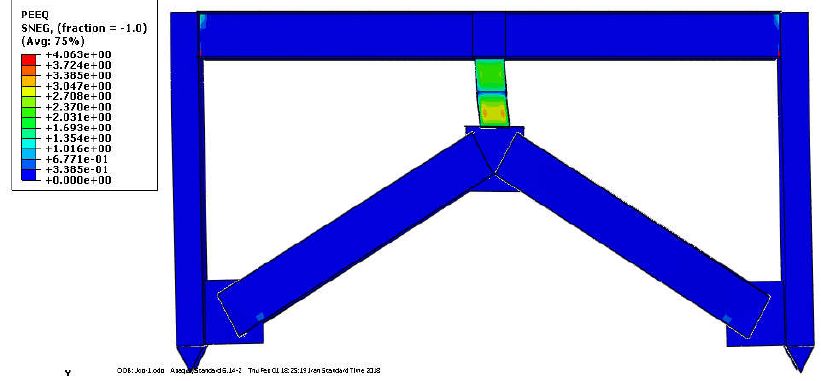
Figure 18. The plastic strain in the frame body.